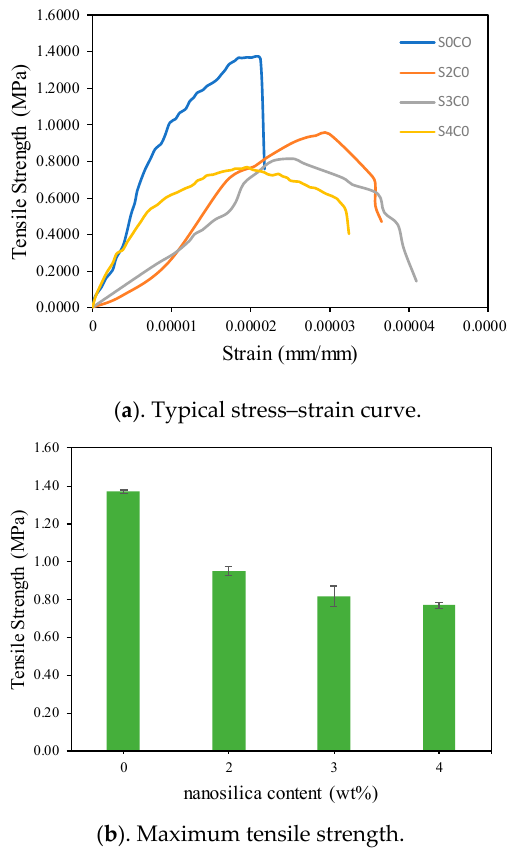
Figure 4. Direct tensile tests results: ( a ) Typical stress–strain curve, ( b ) maximum tensile strength.